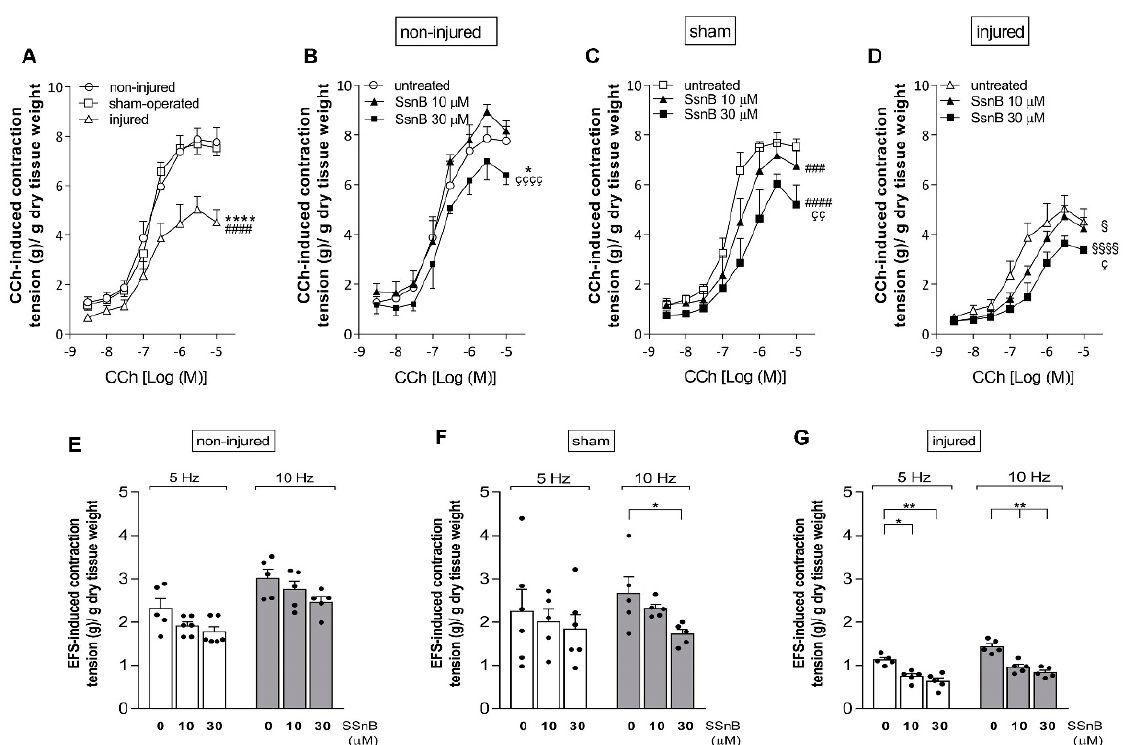
Figure 8. Blockade of TLR2/4 receptors reduces carbachol—and EFS—induced contractions of the rat small intestine after IRI injury. ( A – D ) Concentration–response curves to carbachol (CCh) of the rat small intestine longitudinal muscle in the absence and presence of Sparstolonin B (SsnB) 10 and 30 µM (N = 5 rats per group). * p < 0.05, **** p < 0.001 vs non-injured; ### p < 0.001 #### p < 0.0001 vs. sham-operated; § p < 0.05 vs. injured; ç P < 0.05; çç p < 0.01 and çççç p < 0.0001 vs. SsnB 10 µM in the respective group by Two-way ANOVA with Tukey’s test ( A , B ). ( E – G ) Excitatory responses induced by EFS at 5 Hz (white columns) and at 10 Hz (grey columns) in the rat small intestine longitudinal muscle of non-injured ( E ), sham-operated ( F ) and injured ( G ) groups in the absence and presence of SsnB 10 µM and 30 µM as indicated on the bottom of graphs. Data are reported as mean ± SEM. N = 5 rat/group. Statistical significance: * p < 0.05, ** p < 0.01 by one-way ANOVA with Tukey’s post hoc test.